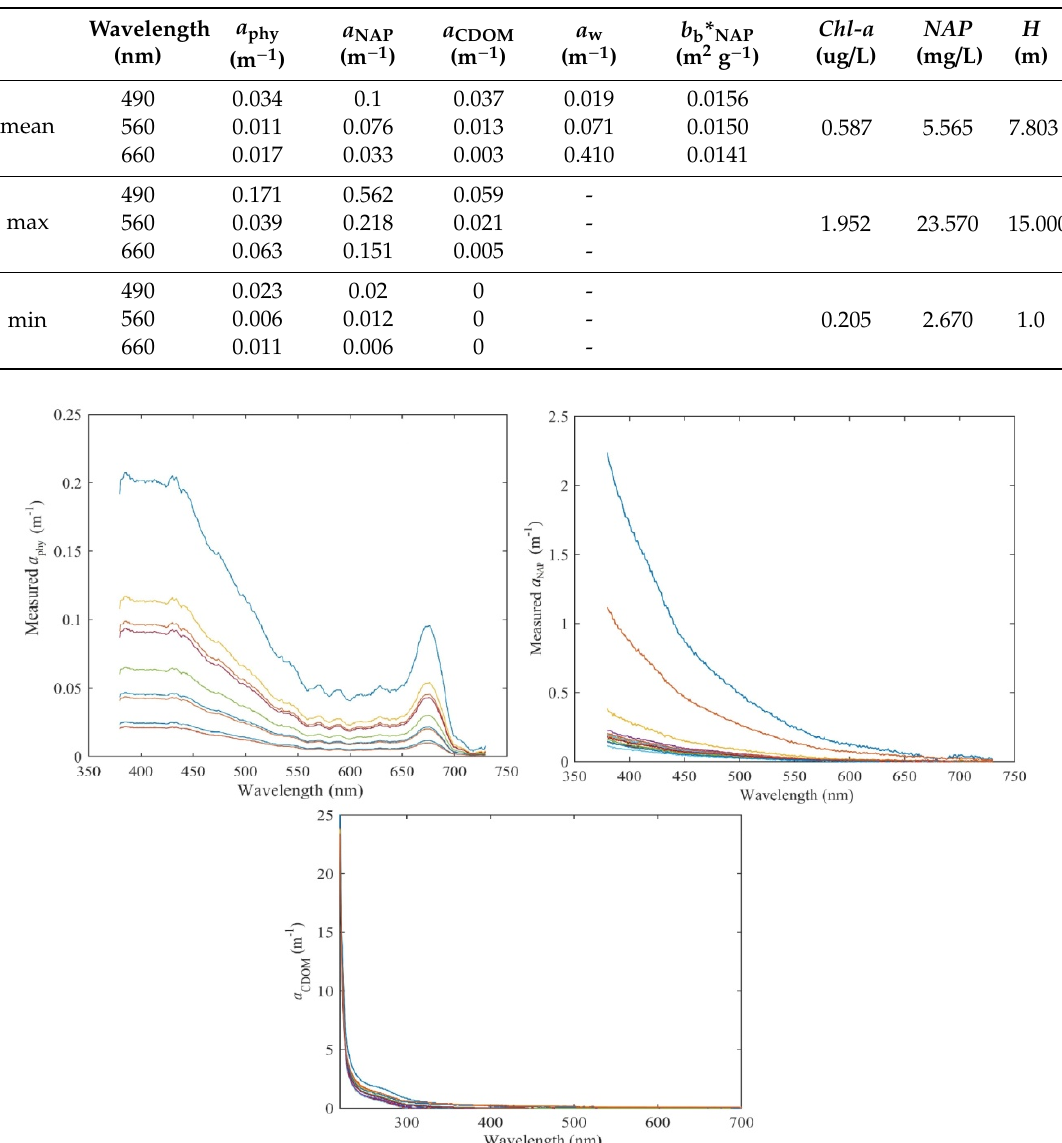
Figure 2. The measured absorption coefficients of chlorophyll-a (Chl-a), non-algal particle (NAP), and colored dissolved organic matter (CDOM).